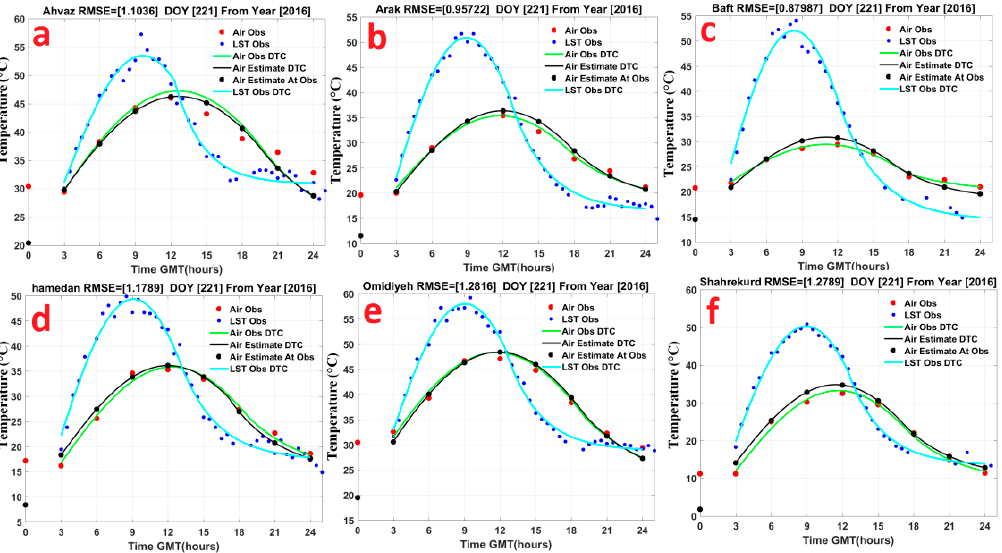
were higher than (cid:1846) (cid:3040)(cid:3036)(cid:3041) values in air DTC model.